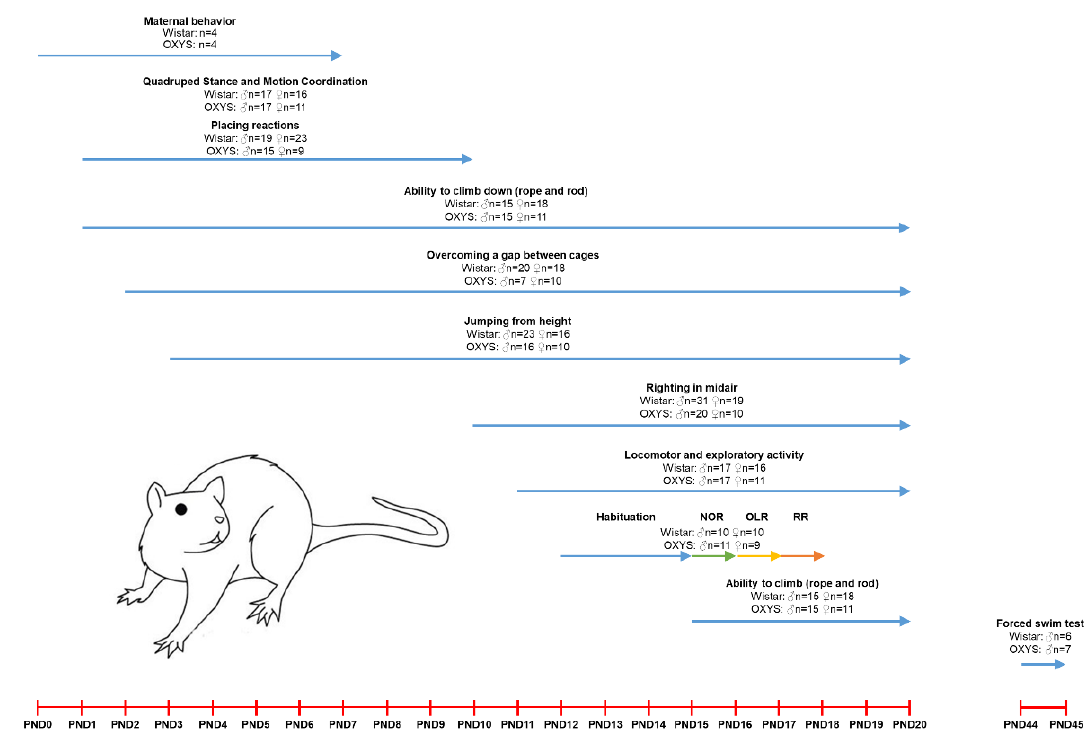
Figure 1. The scheme of the experiment.